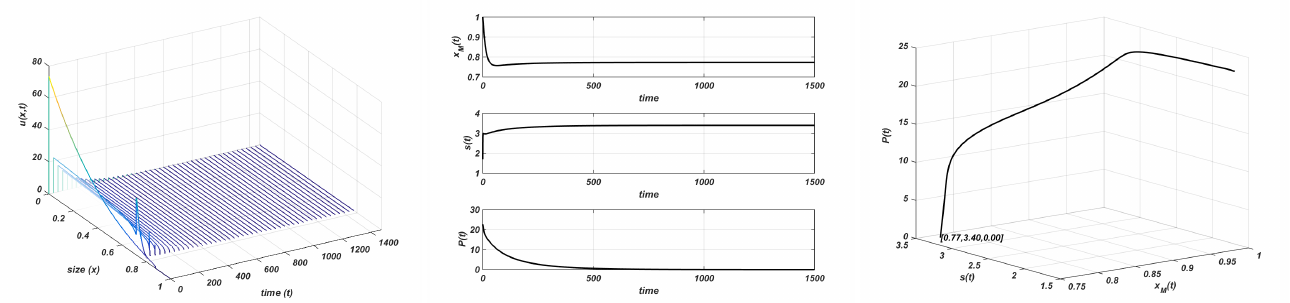
Figure 2. Chemostat growth. r = 4.5 and K = 3.4. Stable equilibria: consumer extinction. Plot on the left : evolution of the structure of the consumer; plot in the centre : evolution of the maximum size, resource, and total consumer population to the equilibrium; plot on the right : orbit followed towards the equilibrium ( 0.77,3.4,0 ) .